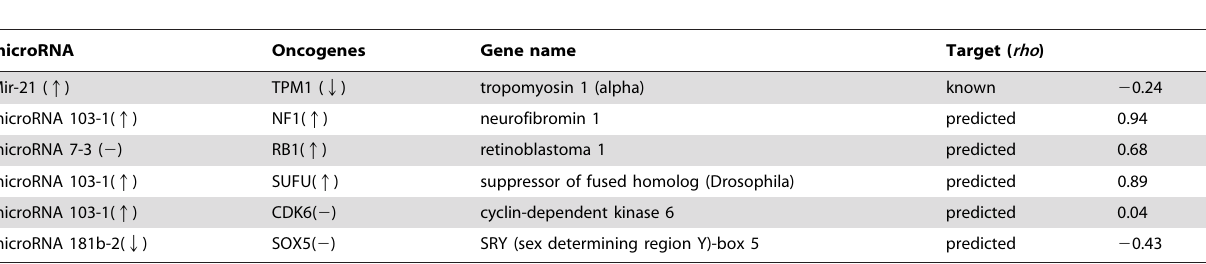
Table 2. Correlation of expression between ovarian cancer-associated microRNA and their target oncogenes ( q and Q represent, respectively, the up-regulation and down-regulation of gene expression in response to LH treatment, ‘‘ 2 ’’ means that no significant expression change was